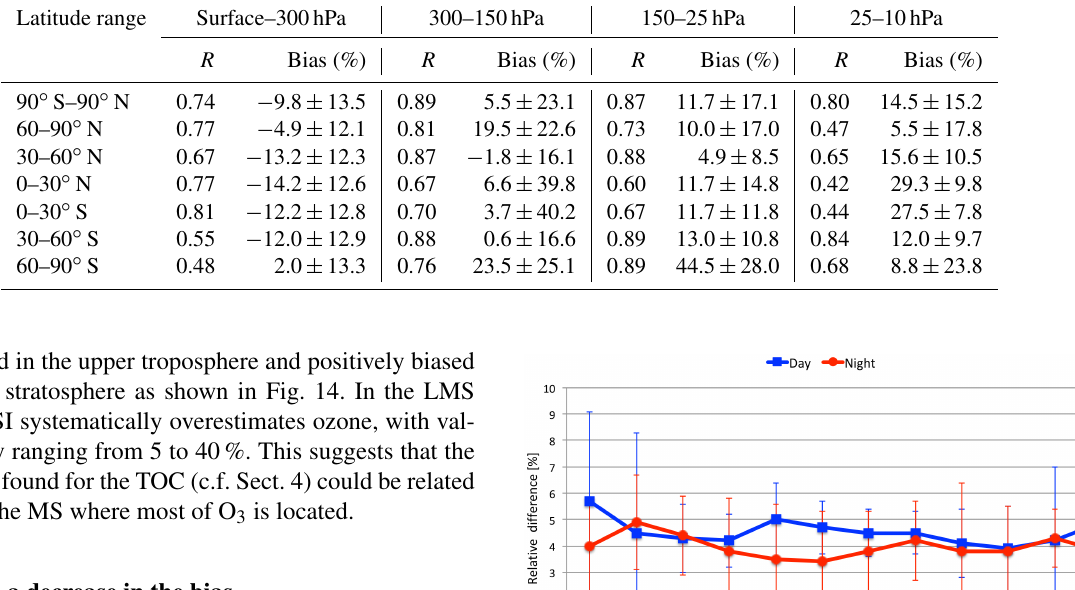
measurements separately. The data were averaged over a 1 ◦ × 1 ◦ grid. The relative differences between both versions of FORLI-O3 range between 3 and 6 % depending on month and observation time. With FORLI-O3 v20151001, there is evidence that retrieved total O 3 columns are lower by 3–6 % and that this will lead to a marked improvement of the